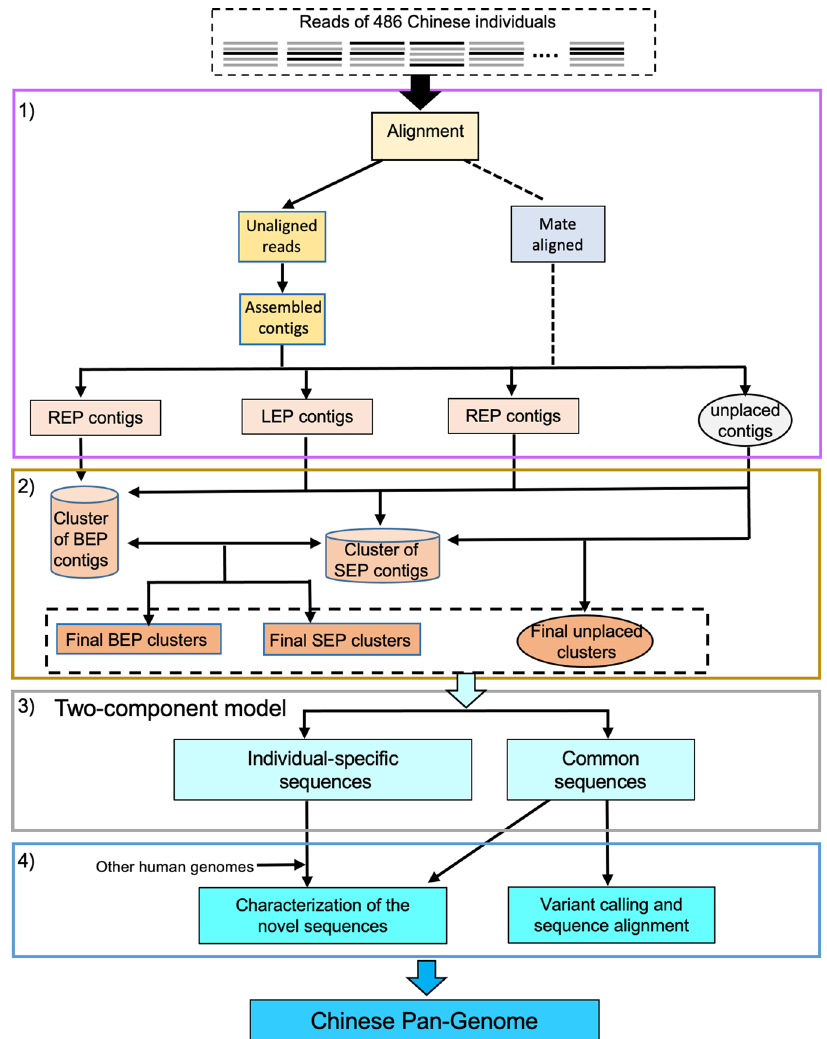
Fig. 2 Work fl ow for construction of a Chinese pan-genome (CPG). There are four procedures for construction of CPG, (1) generation of four types of contigs, right-end-placed (REP), left-end-placed (LEP), both-end-placed (BEP), and unplaced contigs; (2) identi fi cation of the novel representative sequences; (3) modeling of two-component common and individual-speci fi c sequences; (4) further analysis of Chinese Pan-Genome. The fi rst two procedures were in accordance with the APG